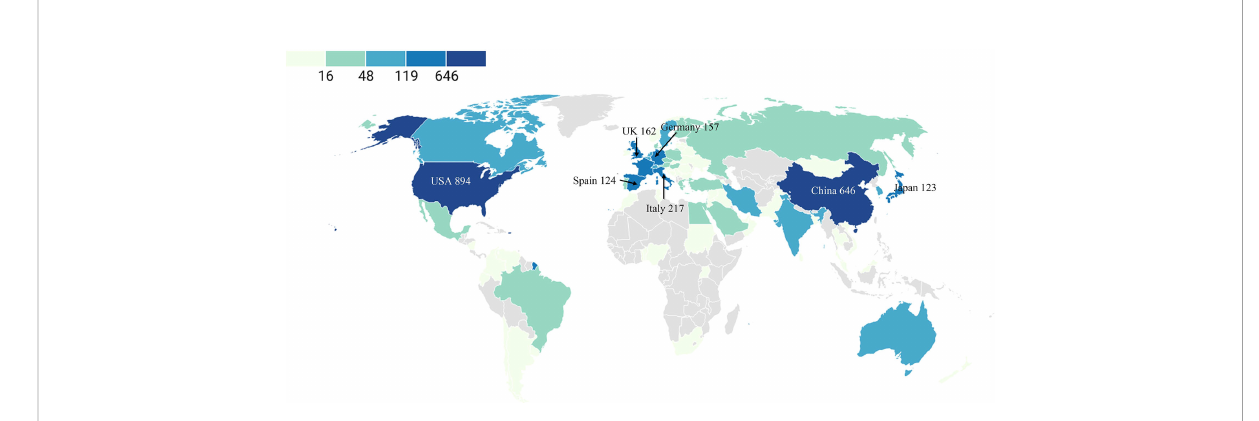
FIGURE 3 Geographic distribution map based on the total publications of different